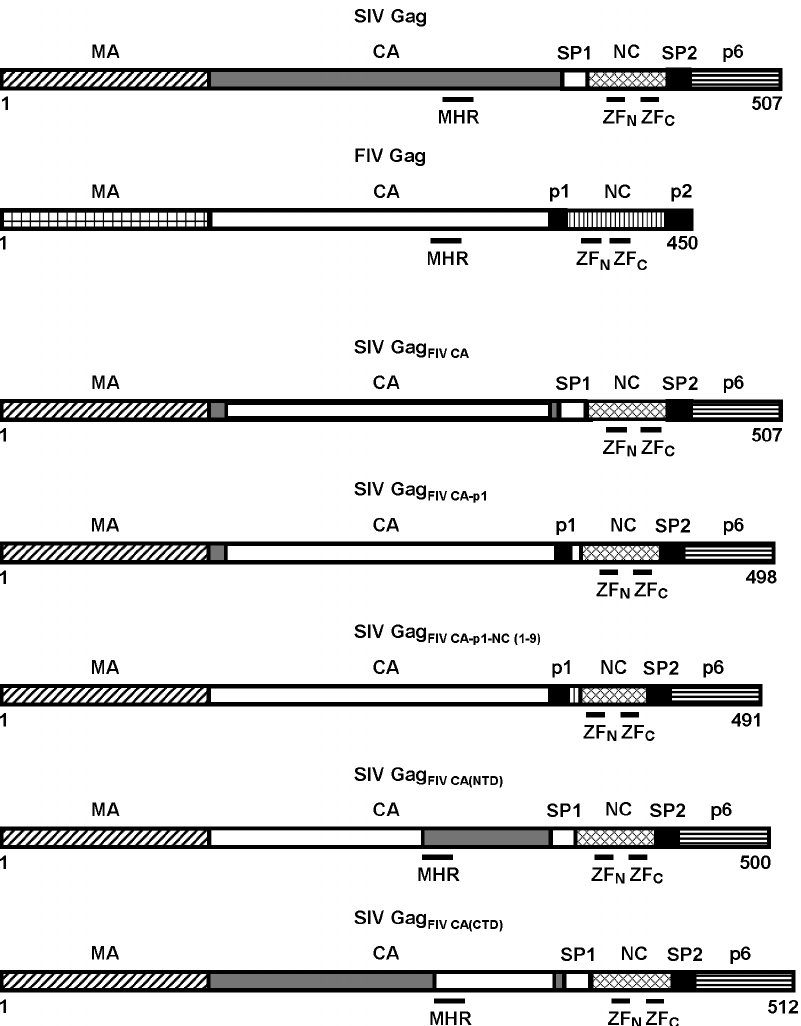
Figure 1. Schematic diagram of the chimeric Gag polyproteins encoded by the proviral SIV constructs. The organization of the wild-type SIV and FIV Gag precursors is depicted at the top showing the structurally conserved domains (MA, CA, and NC), the C-terminal p6 domain in SIV Gag, as well as the spacer peptides (SP1 and SP2 in SIV Gag; p1 and p2 in FIV Gag). The positions of the CA MHR, and the N-terminal (ZFN) and C-terminal (ZFC) zinc-finger motifs in the NC domains of both SIV and FIV Gag proteins are indicated: The numbers refer to the length of each of the chimeric Gag polyproteins with residue 1 corresponding to the initiator methionine in the Gag